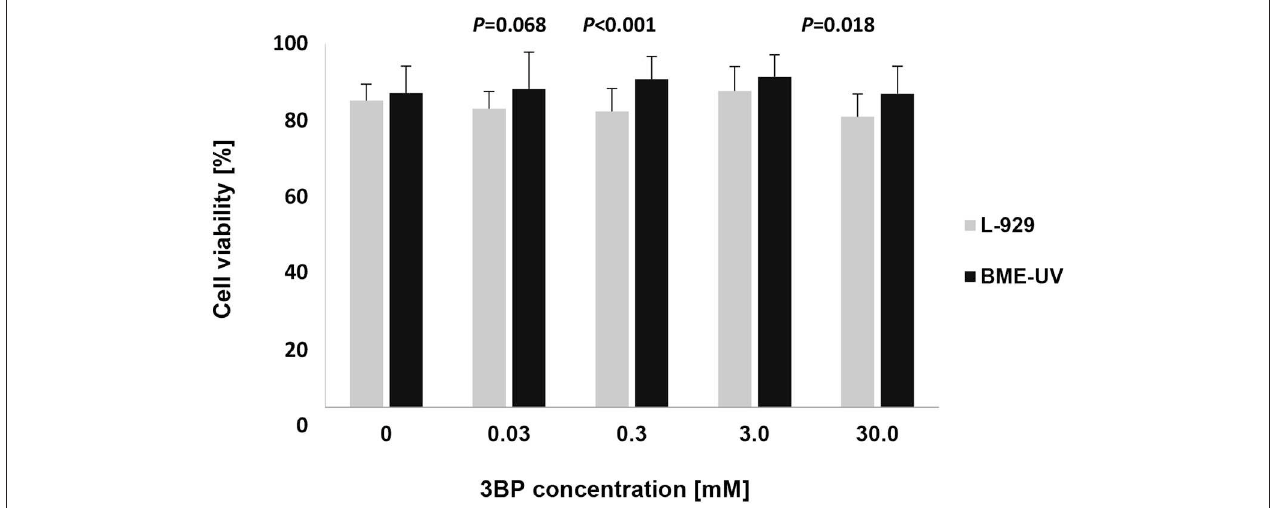
FIGURE 6 | Viability of cultured murine fibroblasts (L-929) and bovine mammary epithelial cells (BME-UV1) determined using LIVE/DEAD Viability/Cytotoxicity assay. Gray and black bars represent viability of L-929 and BME-UV cells, respectively. Data are expressed as mean percentage ± SD of six experiments, each performed in